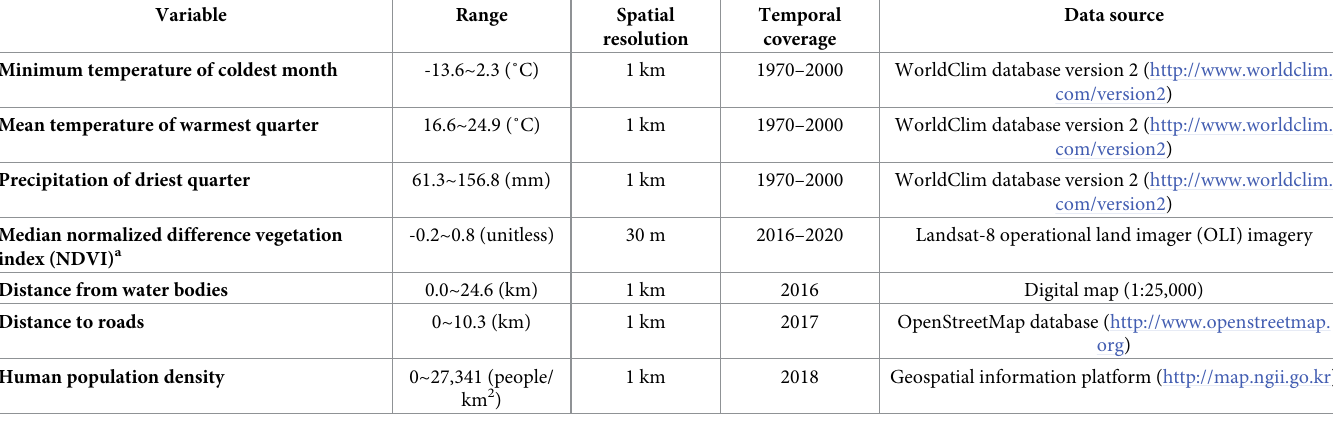
Table 1. Bioclimatic and environmental variables used in ensemble species distribution